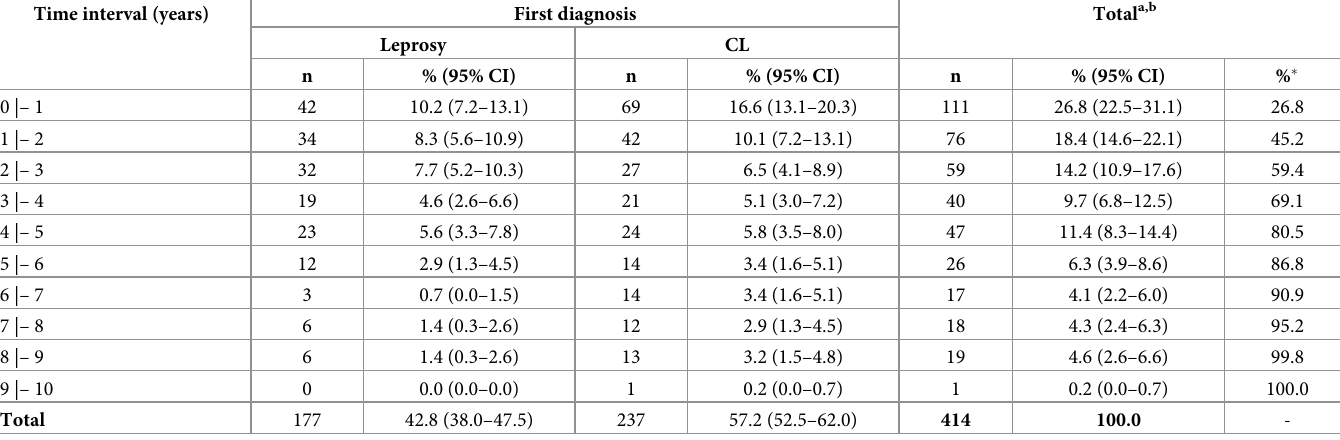
Table 1. Frequency distribution of patients diagnosed with leprosy and cutaneous leishmaniasis (CL) according to the time interval until the diagnosis of the second disease and the order of diagnosis. Data from Mato Grosso state, Brazil, 2008–2017. Time interval